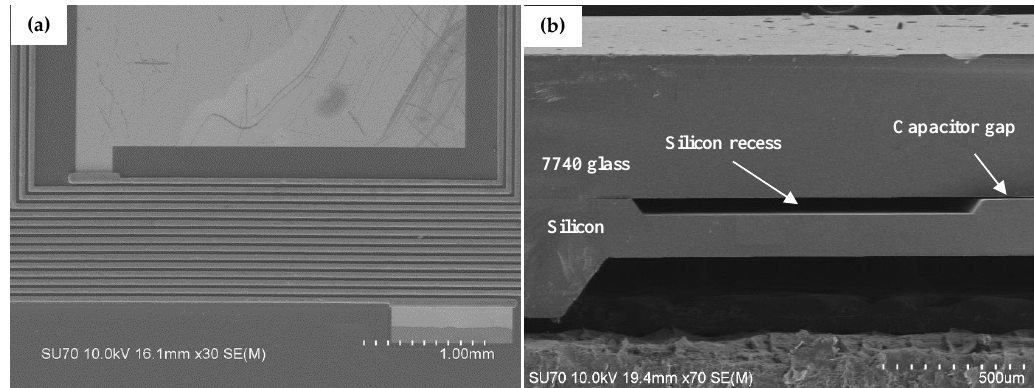
Figure 6. ( a ) SEM photograph of part of the coil and plate; ( b ) SEM photograph of a sensor showing